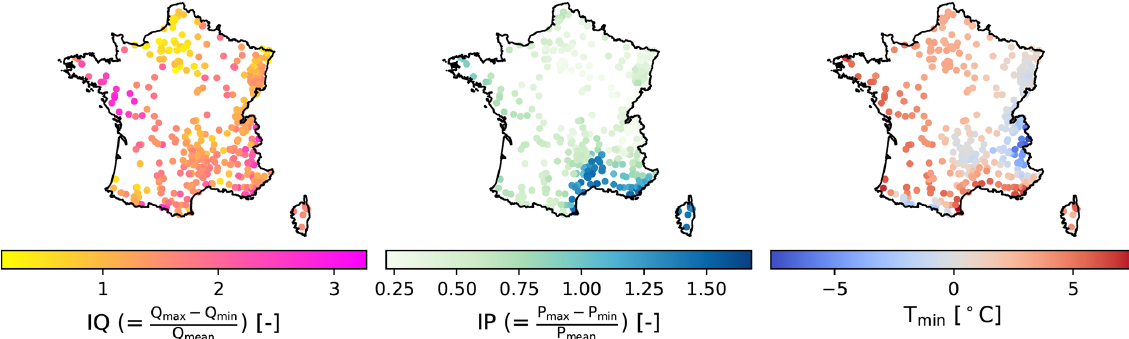
Figure 1. Spatial variation in the three indices used for hydrologic catchment classification: IQ, IP, and T min . Each catchment in the sample is shown as a point.